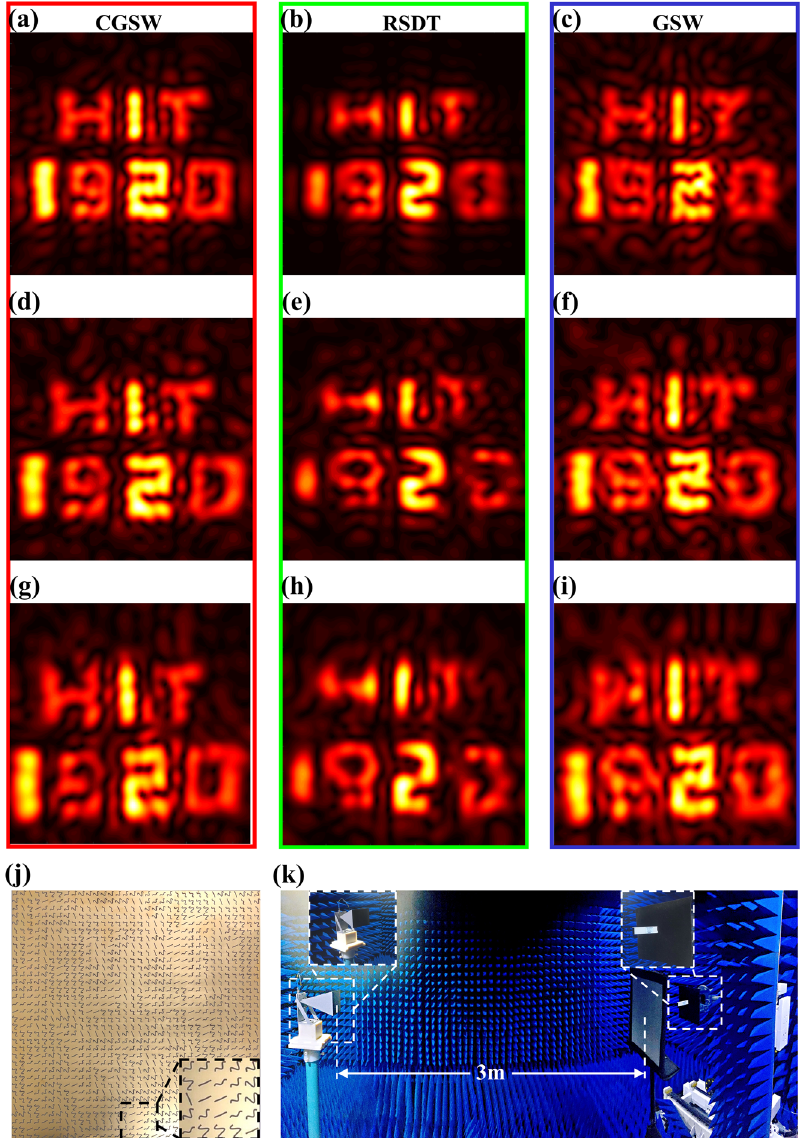
Figure5: Reconstructionof “ HIT1920 ” byCGSW,RSDT,andGSWwhenNA=0.56.Presetamplitudesof “ H, ”“ I, ”“ T, ”“ 1, ”“ 9, ”“ 2, ” and “ 0 ” are different with intensity ratio 1:2:1:2:1:2:1. (a) – (c) Theoretically reconstructed images obtained by three methods. (d) – (f) Full-wave – simulated reconstructed images by the